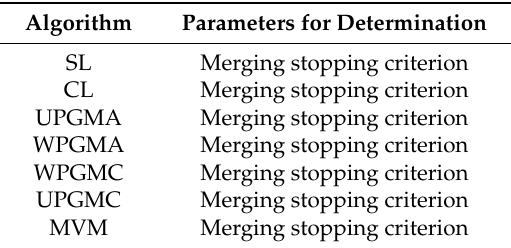
Table 3. Parameters of the hierarchical